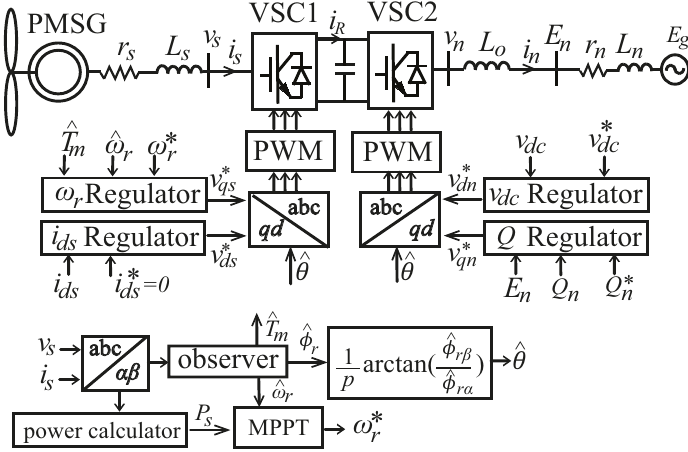
Figure 1. Permanent magnet synchronous generator (PMSG)-based wind energy conversion sys- tem.